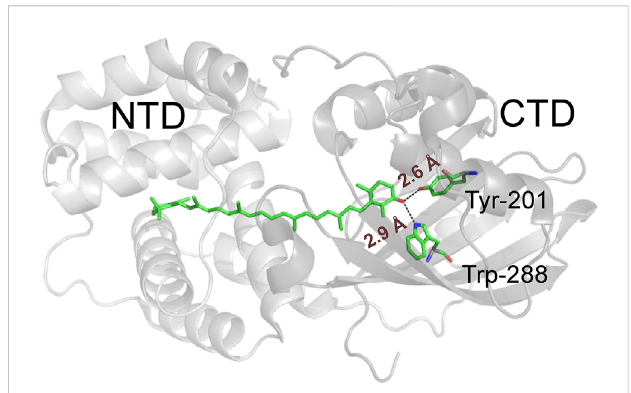
FIGURE 1 Structural representation of wild-type Synechocystis OCP with the N- and C-terminal domains depicted in different shades of grey. The critical H-bond-donating residues (Trp288 and Tyr201) and the ECN cofactor are shown as ball-and-stick models, while the H-bonds are indicated by dashed